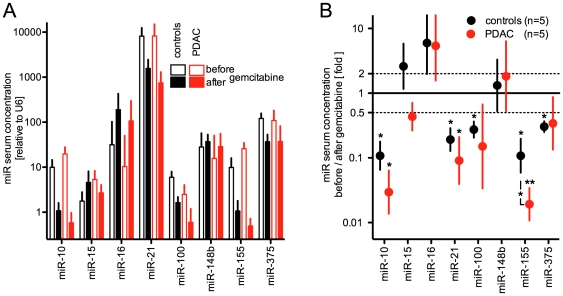
Effect of Gemcitabine treatment on serum miR levels of p48-Cre/LSL-KrasG12D mice with PDAC (red; n = 5) or age-matched control mice (black; n = 5).(A) miR-levels in serum samples harvested before (open bars) and after a one week treatment with Gemcitabine (5 doses of 40 mg/kg). (B) Ratio of serum concentrations before / after Gemcitabine treatment. The dotted line indicates a two-fold difference. *, p<0.05; **, p<0.01.